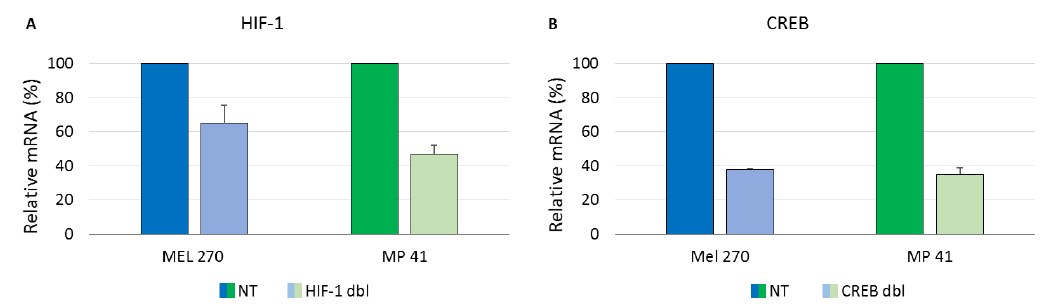
Figure 3. Quantification of knockdown of HIF-1 ( A ) and CREB ( B ) by the armed viruses. mRNA was extracted from fully infected cell lines and mRNA of the two genes was quantified by RT-qPCR relative to β -actin and relative to the expression of these genes in the vACE-NT infected cells, as previously described [16].